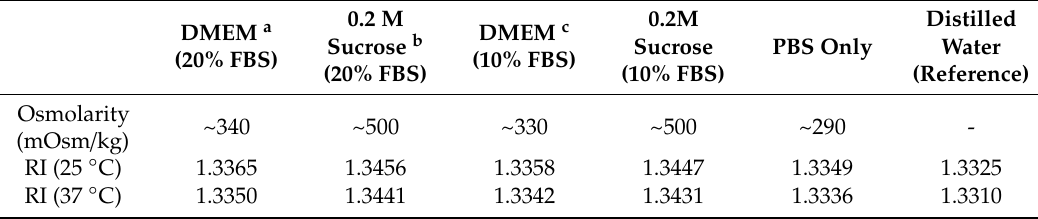
Table 1. Measured osmolarity and refractive indices of culture media and solutions at 25 ◦ C and 37 ◦